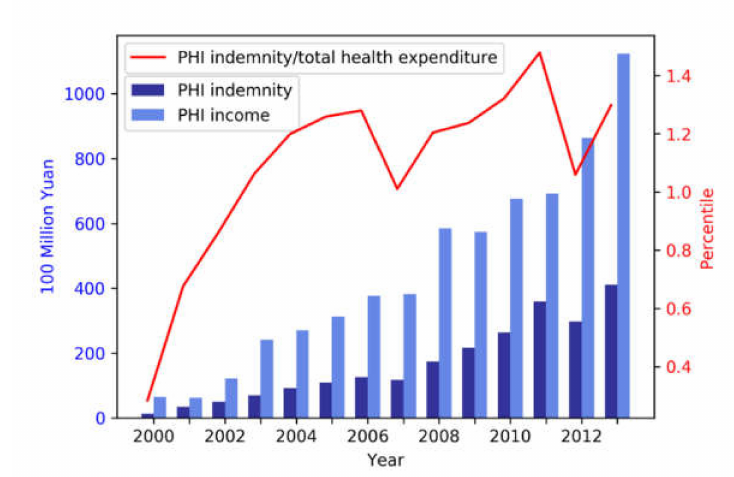
Figure 1. Income and indemnities of private health insurance (PHI), and the share of PHI indemnities in total health expenditure in China. Data source: Yearbook of China’s Insurance 2014 (1 yuan or ¥1 ≈ US$0.14 at the current exchange rate. The following conversations referred to this